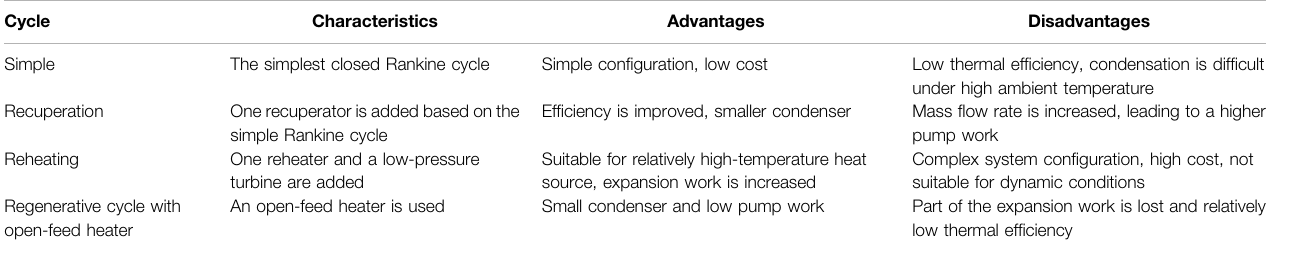
TABLE 7 | Comparison of tCO 2 Rankine cycles for low-temperature